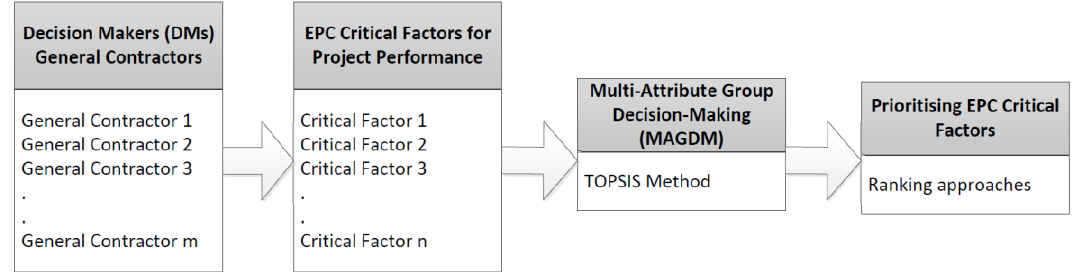
Figure 1. Conceptual diagram for a decision making model.